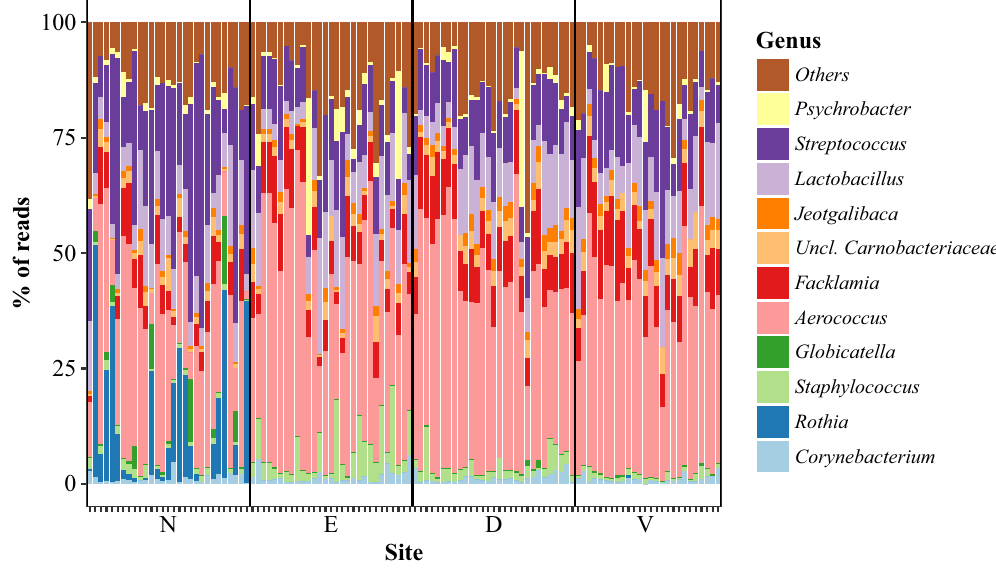
Figure 1. Barplot of amplicons from 16S rRNA gene sequencing. Each column corresponds to a single sample in which the relative abundance of bacterial genera is shown through color coding. N: nose, E: ear, D: dorsal skin surface, V: ventral skin